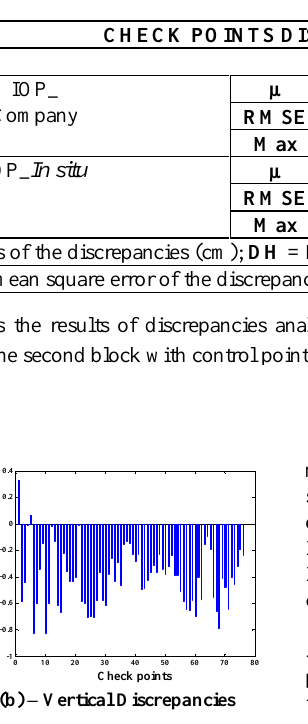
Figure 7. Horizontal e vertical discrepancies of check points (second block) from ISO experiment with control points and IOP from photogrammetric company